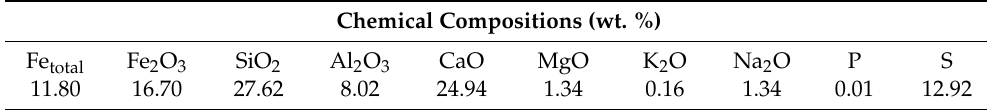
Table 2. Chemical compositions of coal ash (wt. %).